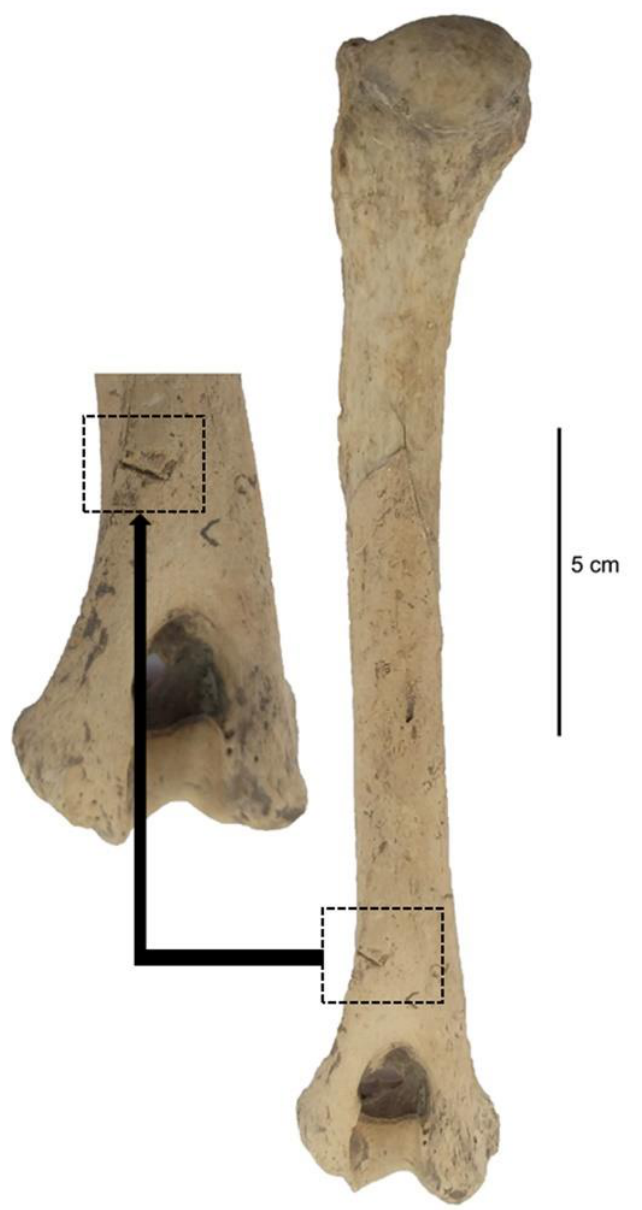
Figure 10. The left humerus of the dog “ALB No. 4” from Alaybeyi Höyük exhibits a deep cut mark.